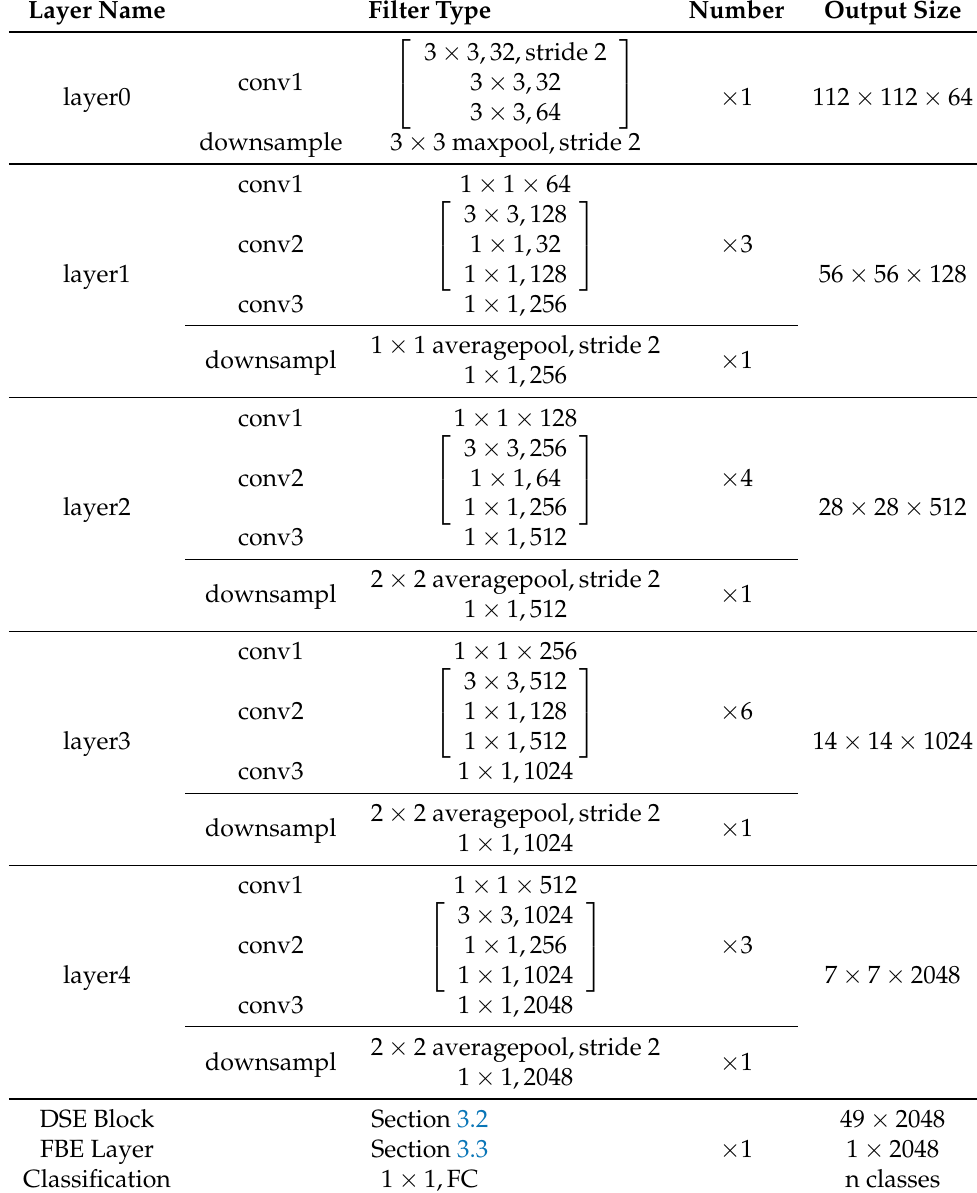
Table 1. The architectures for adopting 50-layer pre-trained ResNeSt. The input image size is 224 ×